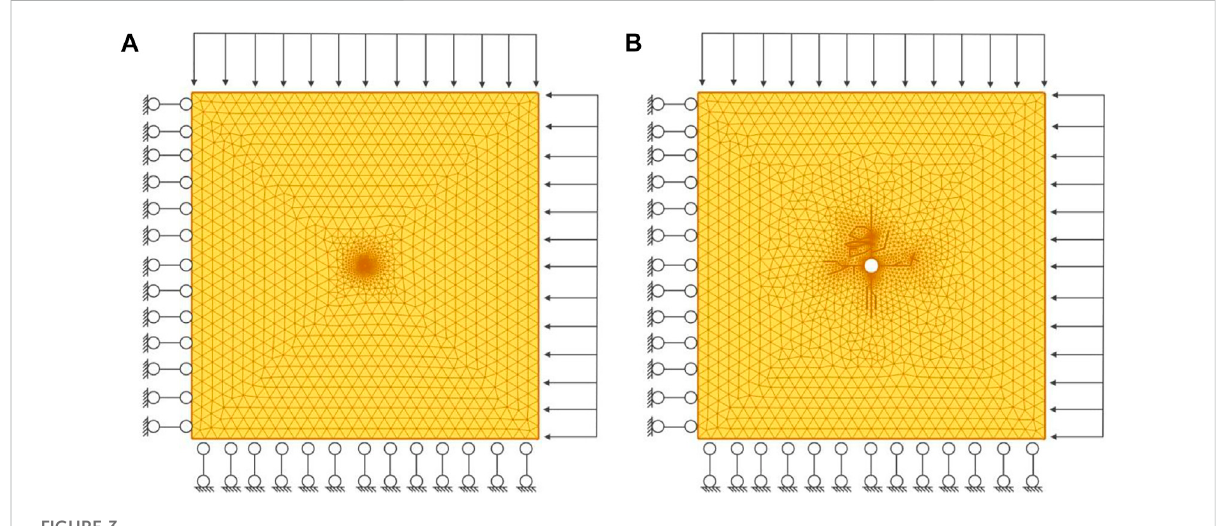
FIGURE 3 Section diagrams of the model and meshing.